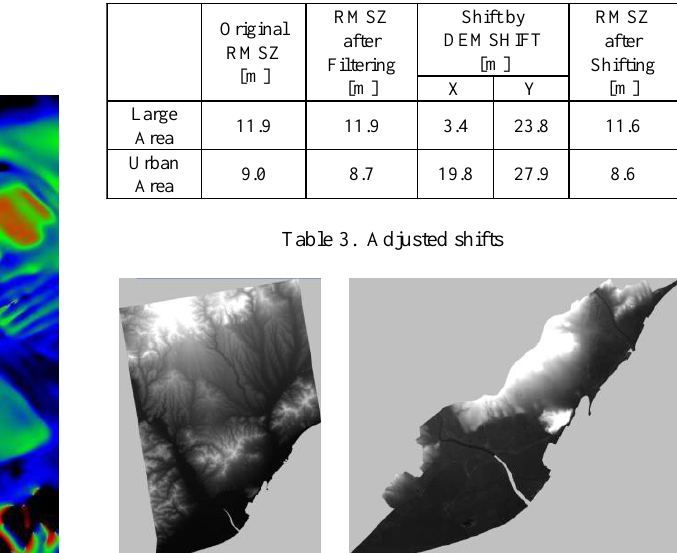
Figure 4. Interferogram after Goldstein filtering